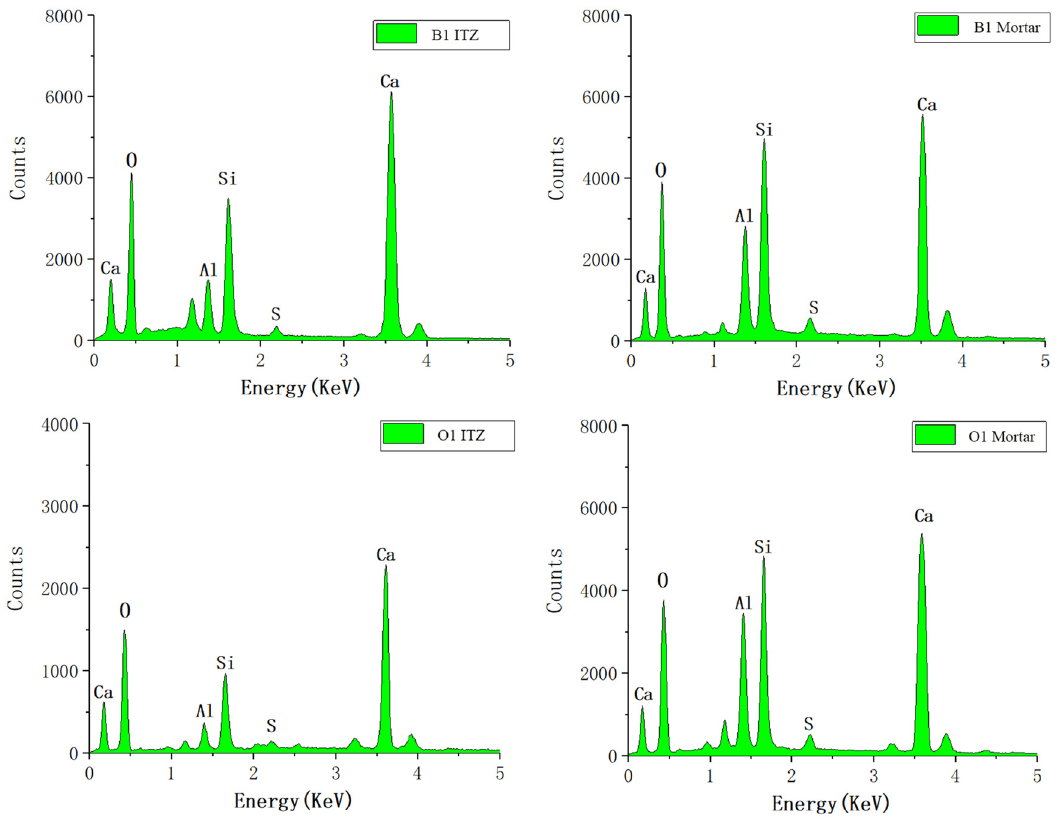
Figure 9: Energy spectra from Element analysis.